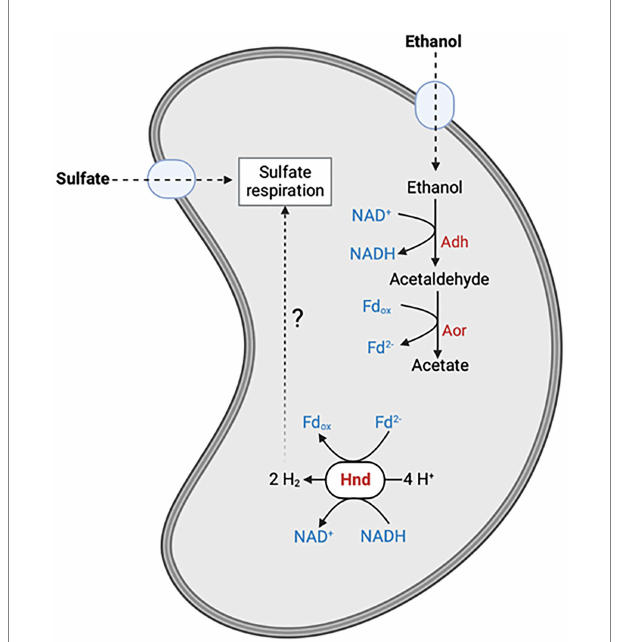
FIGURE 7 Model of the ethanol oxidation pathway in S. fructosivorans . Hnd hydrogenase is involved in the re-oxidation of NADH and reduced ferredoxin which are produced during ethanol oxidation by the enzymes Adh and Aor, through an electron confurcation mechanism. This leads to the production of H 2 which could be recycled for sulfate reduction. The question mark indicates that this electron transfer pathway is hypothetical. Adh, alcohol dehydrogenase; Aor, Aldehyde ferredoxin oxidoreductase; Fd ox , oxidized ferredoxin; Fd 2 − , reduced ferredoxin. This figure was created with